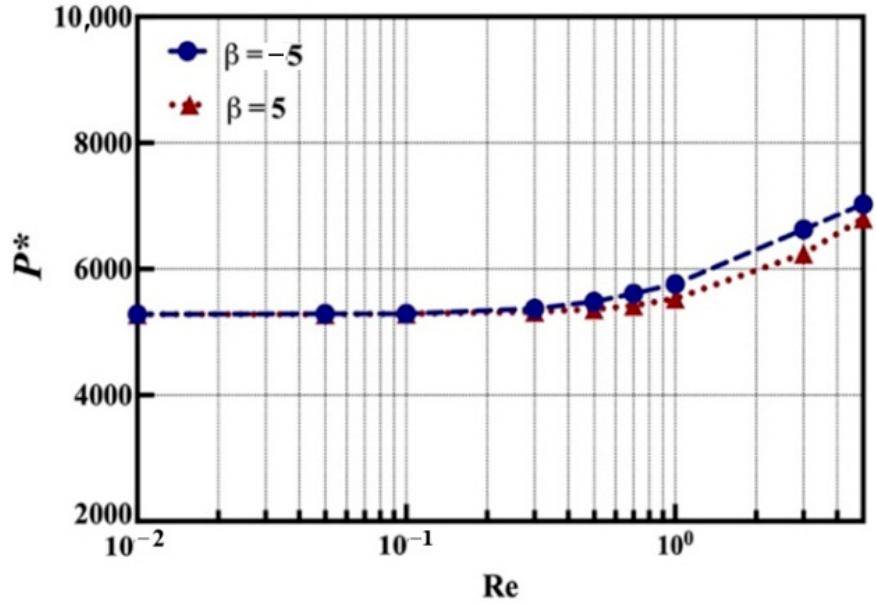
Figure 9. Relationship between P * and Re.